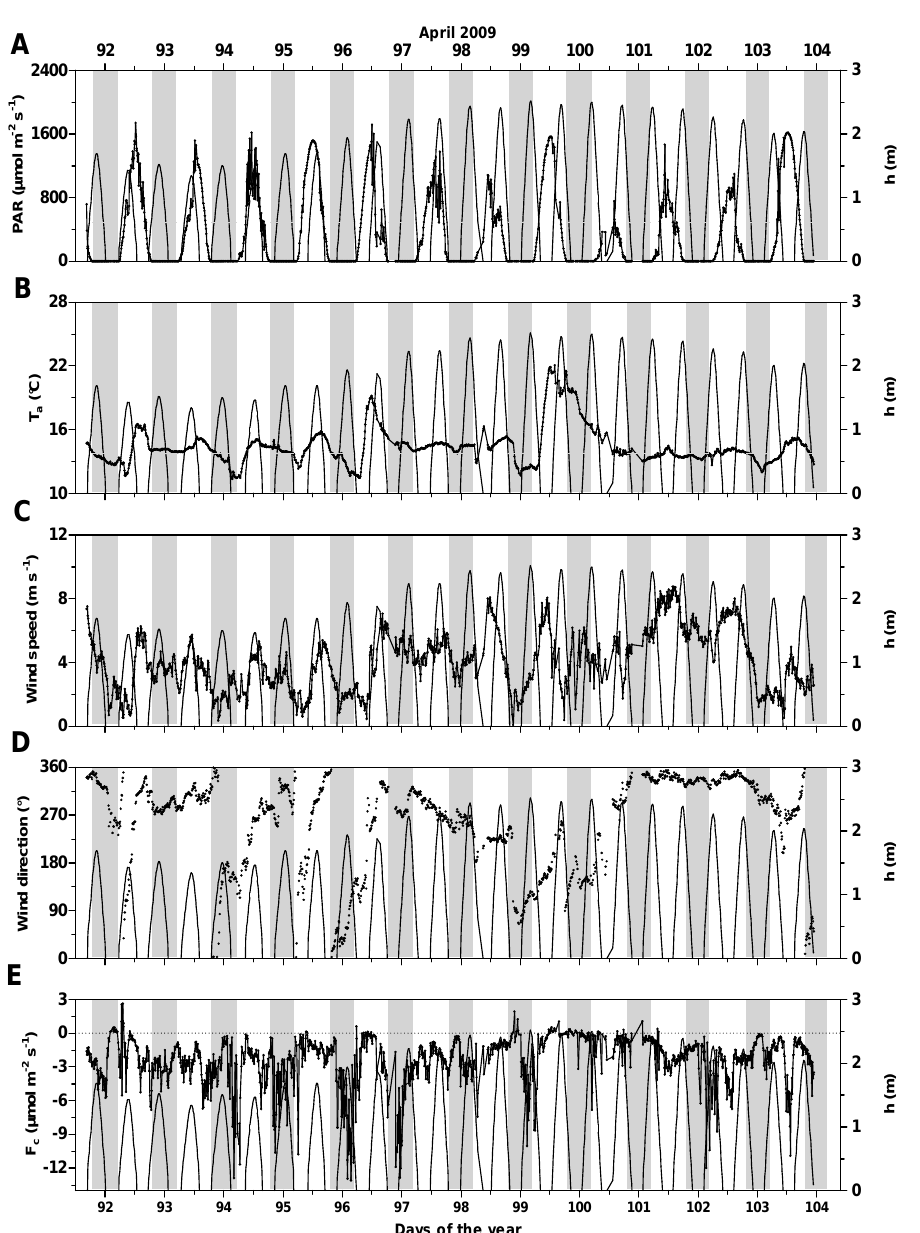
Fig. 6. Environmental parameters and carbon dioxide fluxes measured during the EC deployment in the Arcachon flat (St. 1) from 1 April at 16:30 to 13 April 2009 at 22:50 (GMT). (A) Photosynthetically active radiation PAR (µmolm − 2 s − 1 ) and water height (m); (B) temperature of the air ( ◦ C); (C) wind speed (ms − 1 ) ; (D) wind direction ( ◦ ) and (E) carbon dioxide fluxes (µmolm − 2 s − 1 ) . Negative fluxes represent sinks of CO 2 , and positive fluxes represent sources of CO 2 to the atmosphere by convention. Day 91 squares with the 1 2009 and grey bands represent night periods. A PAR threshold of 20µmolm − 2 s − 1 was chosen to separate day and night cases, and low tide cases correspond to zero-water